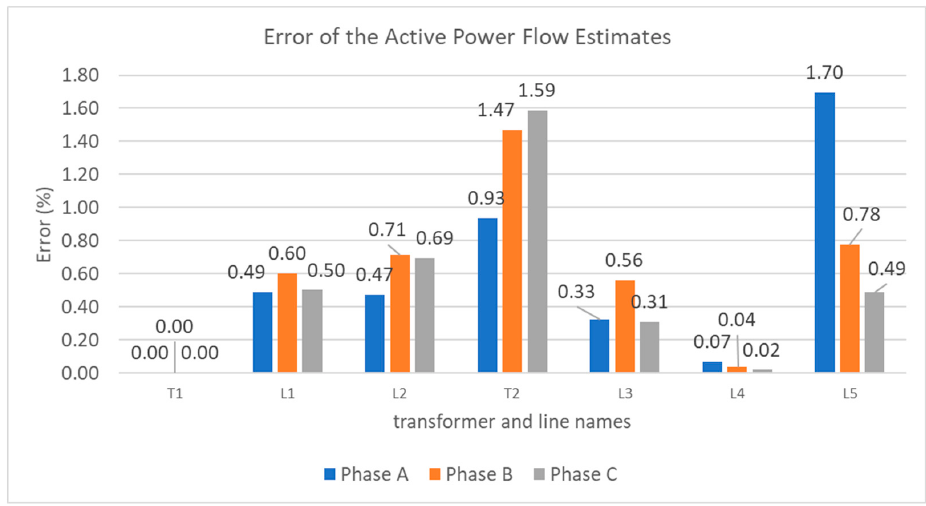
Figure 8. Power flow error in 13-bus distribution network for the first loading condition.